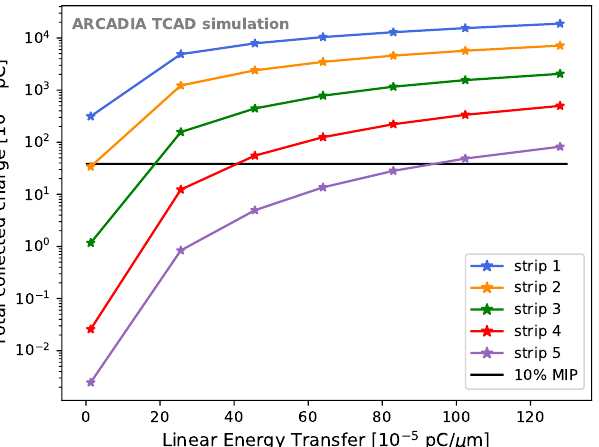
Figure 25. Charge sharing among adjacent microstrips. The total charge collected by strips 1 to 5 (following the nomenclature illustrated in Figure 8) is shown as a function of the